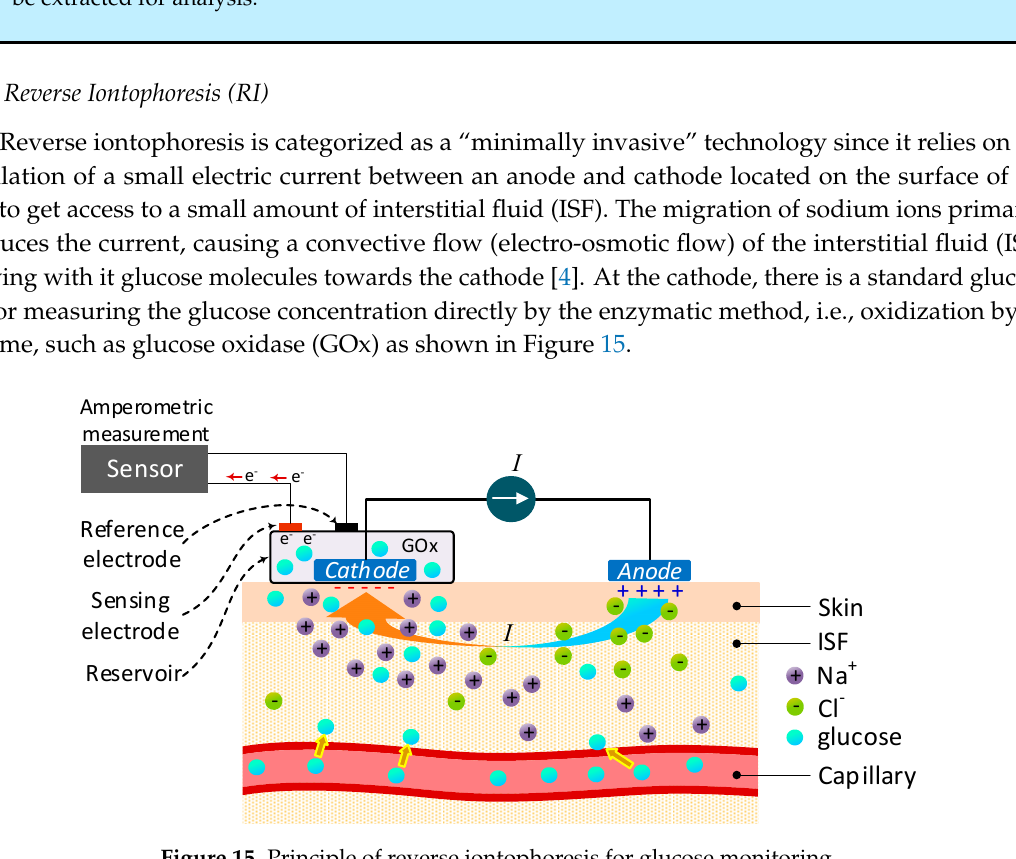
Figure 15. Principle of reverse iontophoresis for glucose monitoring.